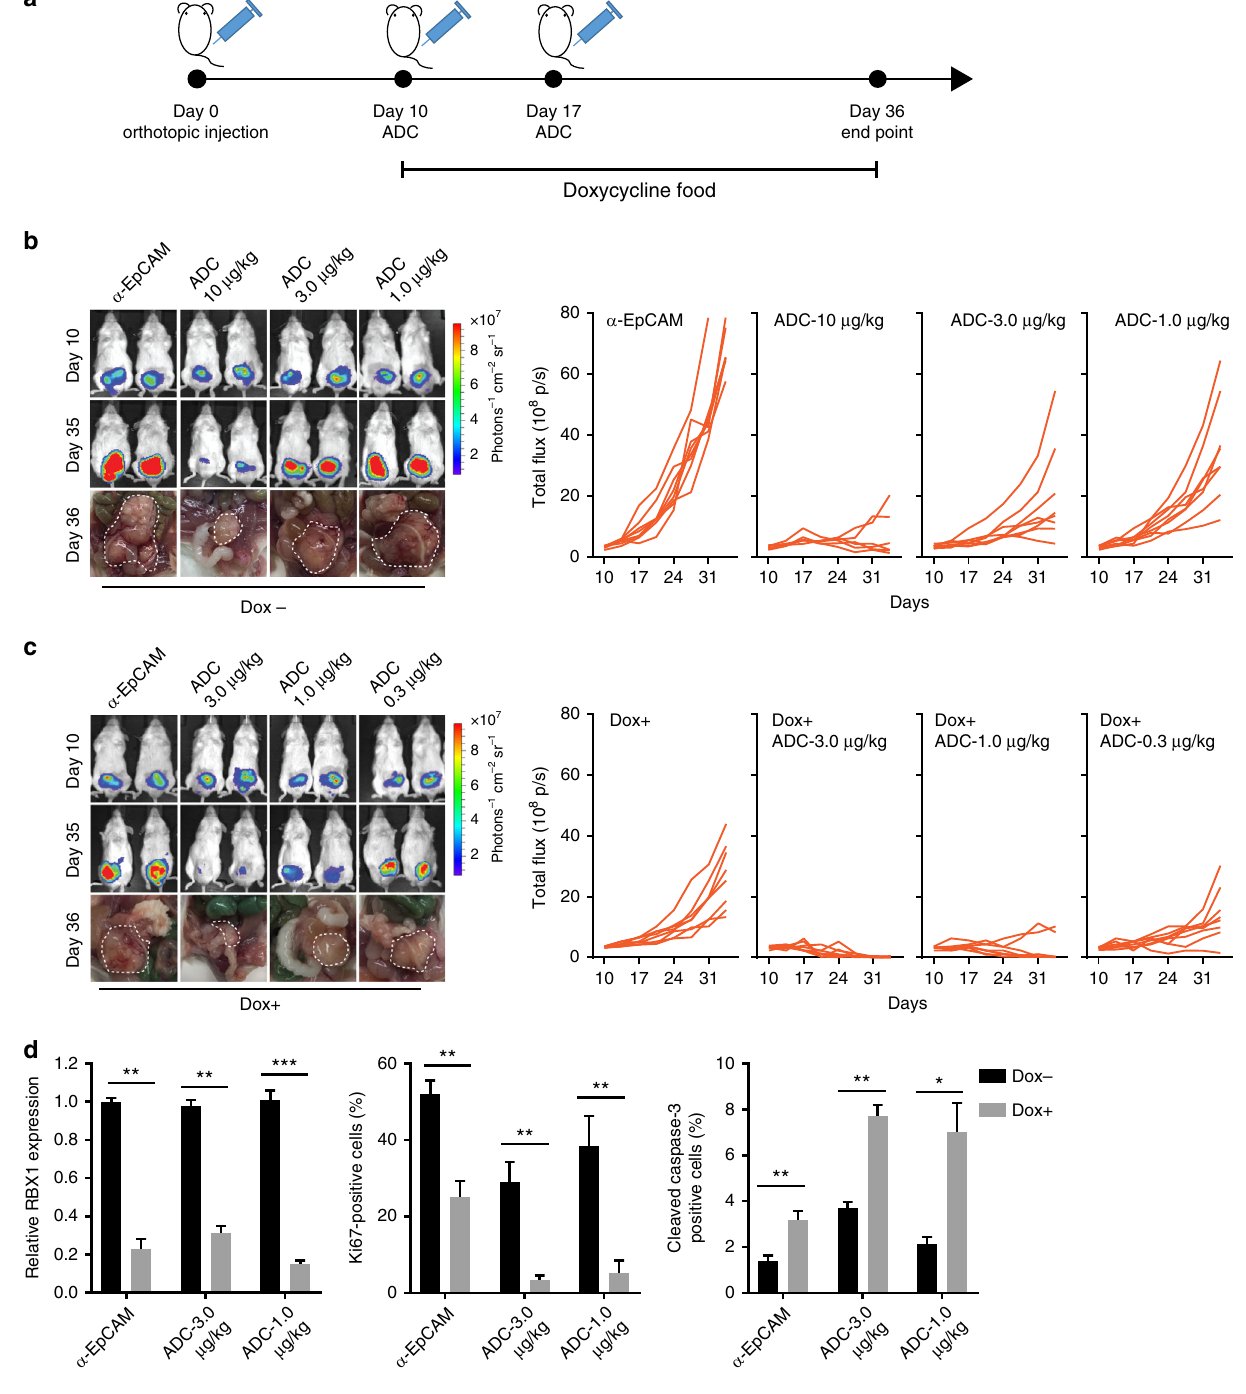
Fig. 8 Inhibition of RBX1 sensitizes 17p loss CRPC to the treatment of α -amanitin-based ADC. a Schematic illustration of orthotopic injection of 17p loss DU145 cells (1× 10 6 cells) followed by twice i.p. injection of ADC and Dox food treatment. b , c Representative bioluminescent tumor images and individual tumor growth curves of xenograft tumors derived from orthotopically implanted 17p loss DU145 cells without ( b ) or with ( c ) Dox treatment. Once tumor was established, mice were randomly divided to 4 groups ( n = 8) and treated with either free anti-EpCAM antibody or different doses of anti-EpCAM-amanitin conjugates (ADC). d Quanti fi cation of RBX1 knockdown ef fi ciency, cell proliferation (Ki-67 staining) and apoptosis (cleaved caspase-3 staining) in the xenografted tumor tissues described above. Data are analyze by unpaired two-tailed t -test and are presented as the mean ±SD. **, p < 0.01; ***, p <